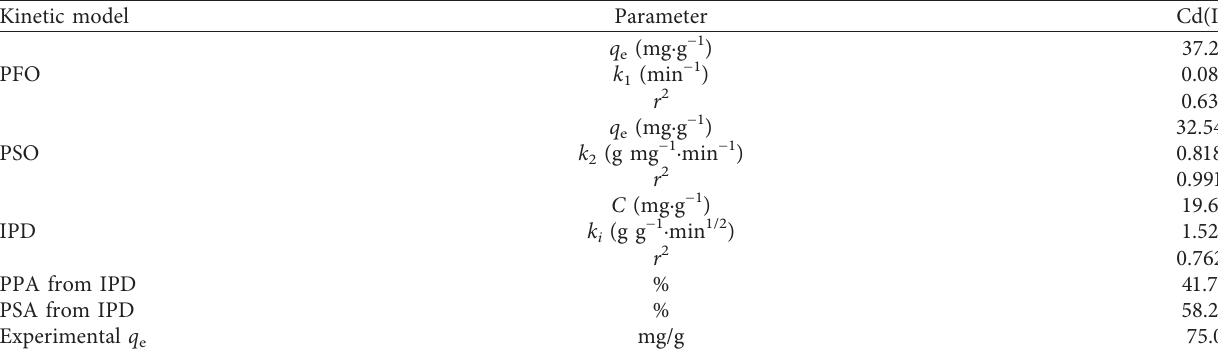
Table 2: Kinetic model parameters for Cd(II) adsorption.